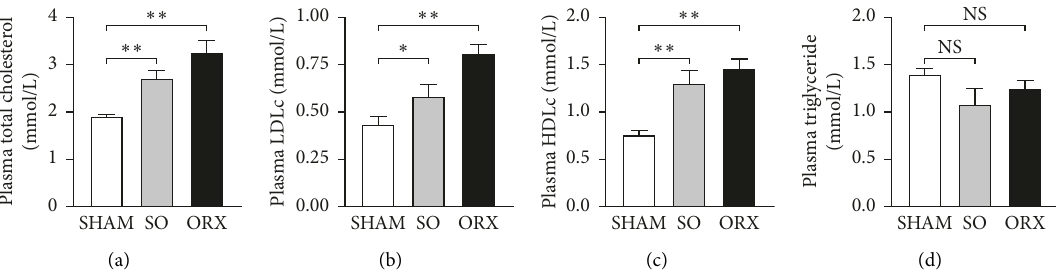
Figure 2: Testosterone deficiency induced disorder of cholesterol metabolism. (a) Plasma total cholesterol (TC), (b) low-density lipoprotein cholesterol (LDLc), (c) high density lipoprotein cholesterol (HDLc), (d) triglyceride (TG) of the rats. Data are presented as mean Statistical analyses are unpaired t -test or one-way ANOVA.